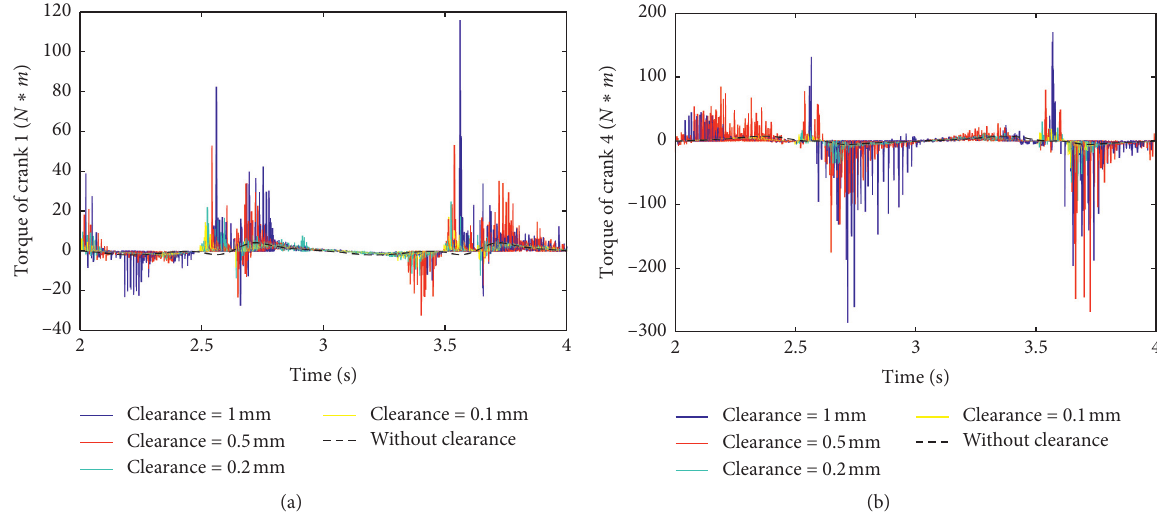
Figure 12: Driving torque of the crank. (a) Driving torque of crank 1. (b) Driving torque of crank 4.